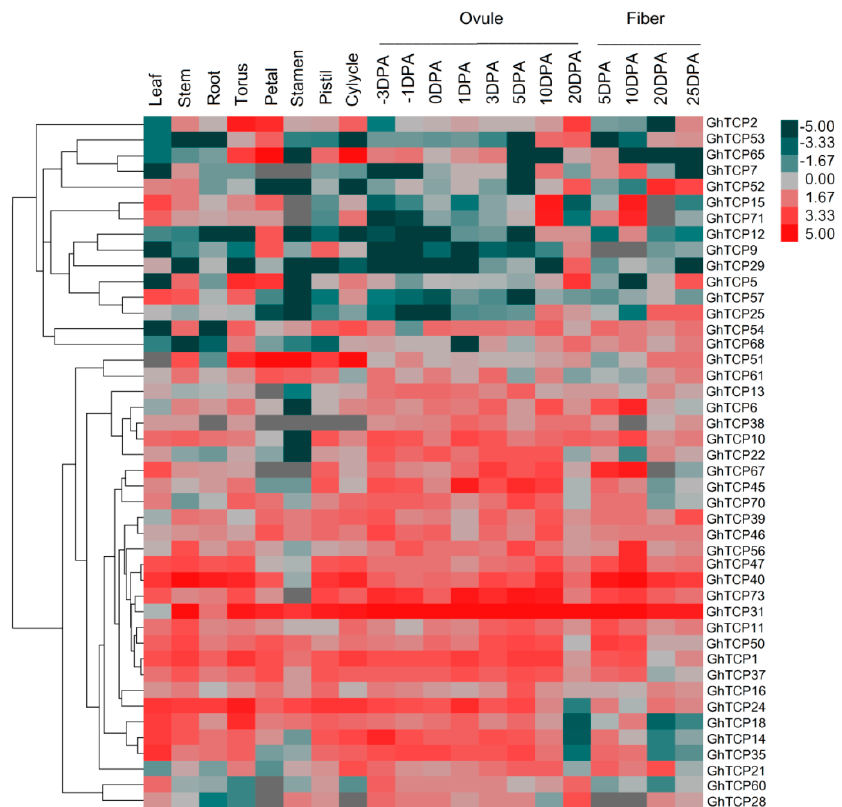
Figure 3. Heat map representation of GhTCP gene expression in different tissues. The tissues used for expression profiling are indicated at the top. The genes are shown on the left of the expression bars and the phylogenetic relationship is shown. The − 3 to 20 days post anthesis (DPA) indicate − 3, − 1, 0, 1, 3, 5, 10, and 20 days after pollination.